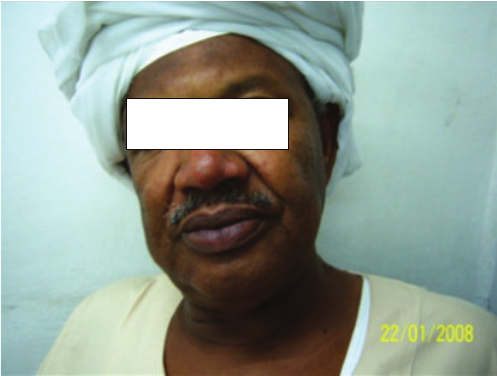
Figure 12: Of patient no. 3 after treatment.